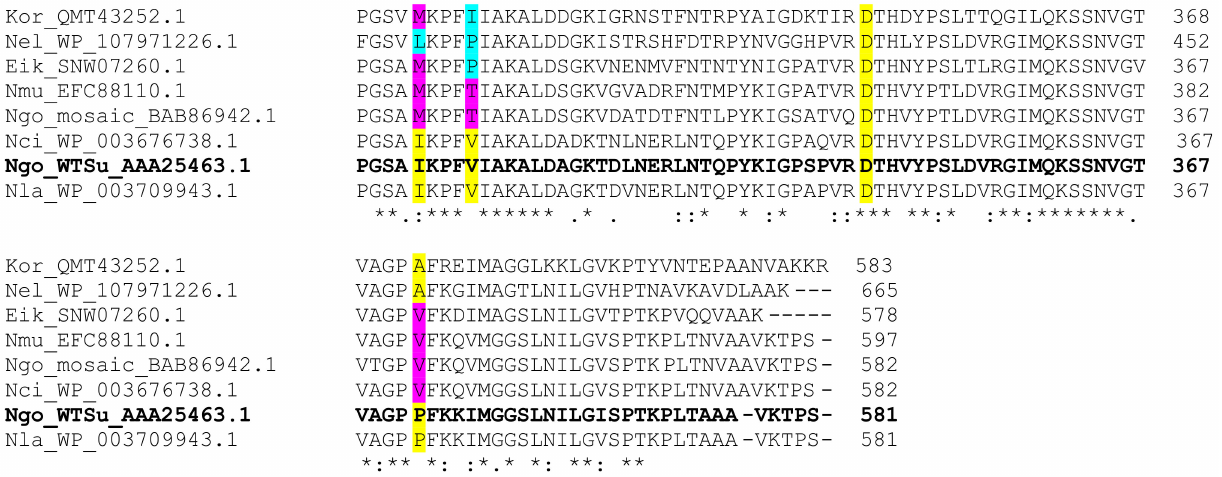
Figure 5. Multiple sequence alignment using ClustalOmega of portions of the PBP2 sequences from 2 N. gonorrhoeae strains, 4 commensal Neisseria species, and 2 non- Neisseria species from the Neisseriaceae family. The sequence for N. gonorrhoeae LM306 susceptible strain is bolded. Amino acid positions identified as relevant for antibiotic resistance (highlighted in yellow) that are mutated in more than one commensal are highlighted in magenta (known mutations), or cyan (undescribed mutations). Kor, Kingella oralis , Nel, N. elongata ; Eik, Eikenella corrodens ; Nmu, N. mucosa ; Ngo, N. gonorrhoeae ; Nci, N. cinerea; Nla, N. lactamica ; WTSu, wild-type susceptible. * (asterisk) indicates identity for all sequences at that position; : (colon) indicates conservation by strong similarity among sequences at that position; . (period) indicates conservation by weak similarity among sequences at that position